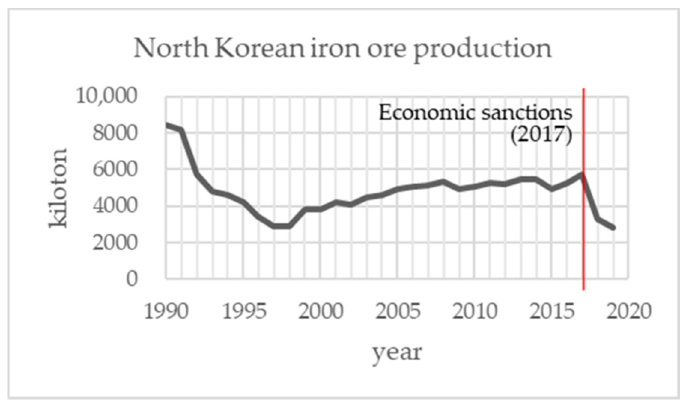
Figure 1. North Korean iron ore production [24]. In this study, two InSAR DEM datasets were used to identify the major elevation changes due to mining activities between 2000 and 2015. Activities for the recent 5 years (2015–2020) were identified using Sentinel-1 InSAR coherence time-series data with a 12-day temporal baseline. A new index, so called the Normalized Difference Activity Index (NDAI), has been developed to highlight the activities and to mitigate decorrelation from other sources, such as precipitation or spatial baseline. Section 2 introduces the study area, data, and methods including the newly developed NDAI. Section 3 presents the research results and discussions, which includes the analysis of NDAI images over all periods, annual variations, and activities that occurred during the 12-day InSAR baseline. Section 4 concludes the paper, highlighting the major